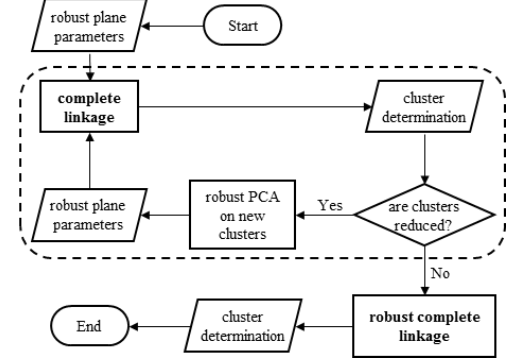
Figure 4. Iterative complete linkage algorithm for robust clustering of planar surfaces